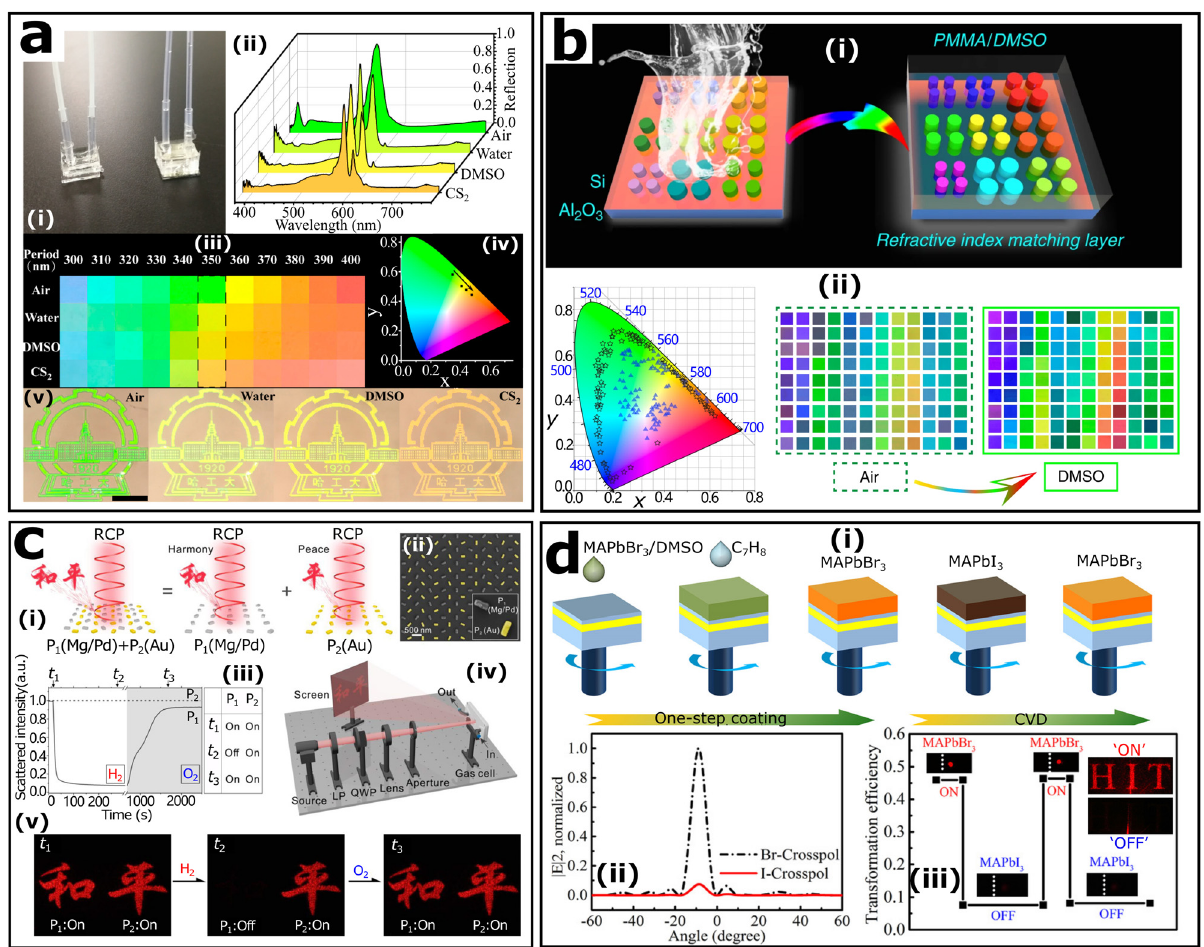
Figure 6: Tunable metasurfaces based on altering surrounding medium and material composition. (a): (i) The tunable metadevices integrated TiO 2 metasurfaces with micro fl uidic chips. (ii) Experimental re fl ection spectra of the metasurface (period: 350 nm) surrounded by different solvents. (iii) Re fl ection colors of metasurfaces with different periods recorded under a bright- fi eld microscope. (iv) Chromatic coordinates of the colors in (ii) marked in the CIE 1931 color space. (v) Color images of the school badge of Harbin Institute of Technology composed by the TiO 2 metasurface. Reproduced with permission from ref. [138]. Copyright 2018, American Chemical